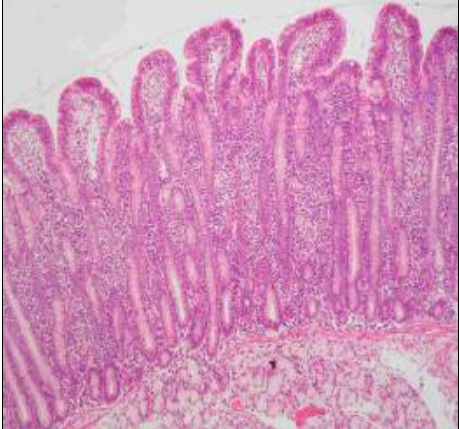
Fig. 11. Piglet duodenum. The 1 st group, the 70 th day of test. H&E. x